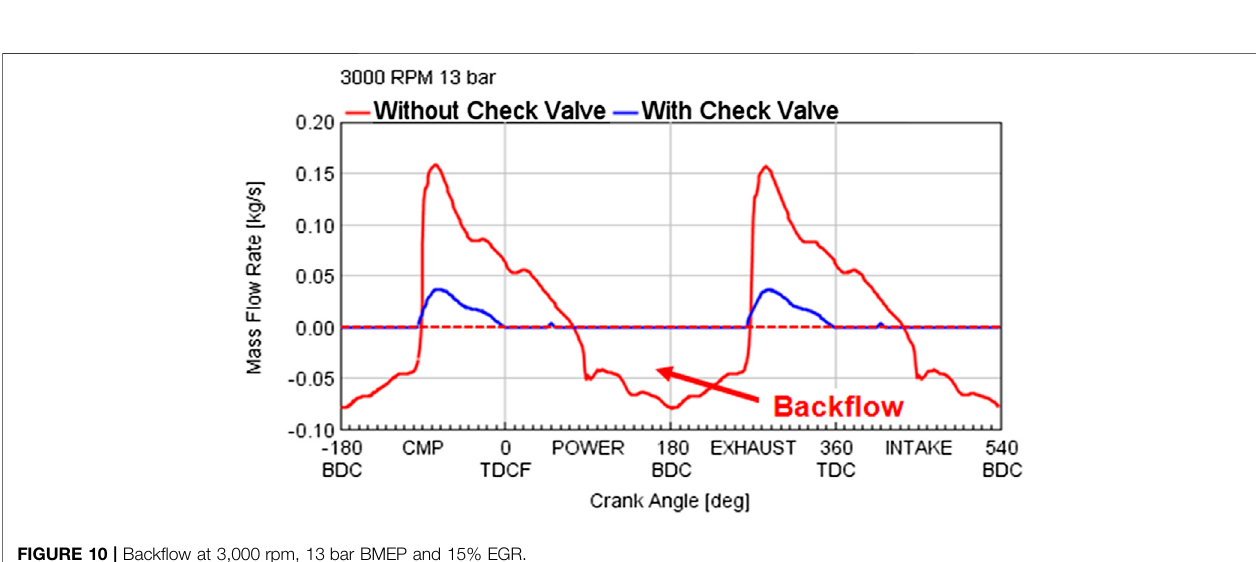
FIGURE 10 | Back fl ow at 3,000 rpm, 13 bar BMEP and 15% EGR.